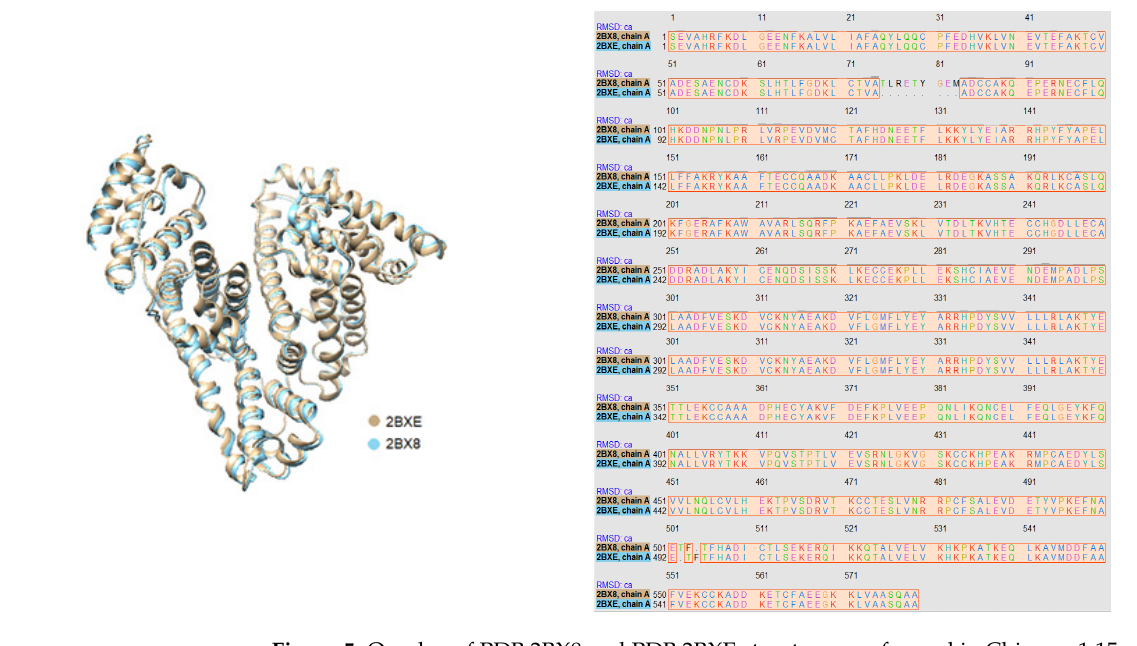
Figure 5. Overlay of PDB 2BX8 and PDB 2BXE structures performed in Chimera 1.15 software and representation of the sequence of the amino acid alignment of the structures.